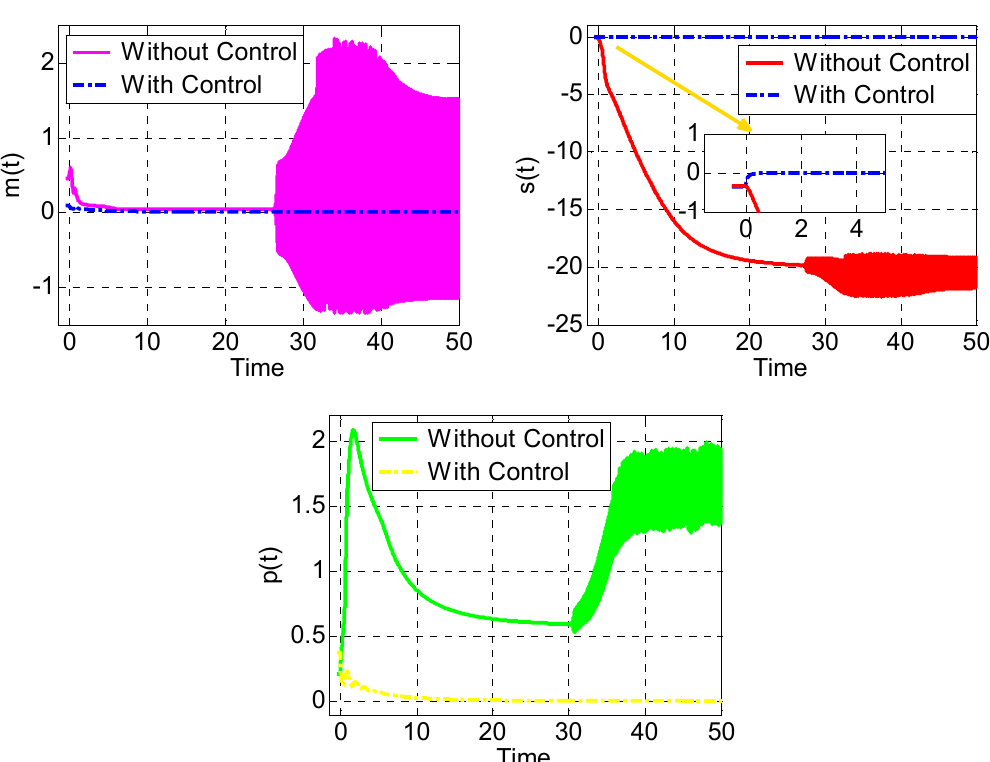
Figure 9. Contrasting time response of the three-dimension FOGRN when α = 0.8.